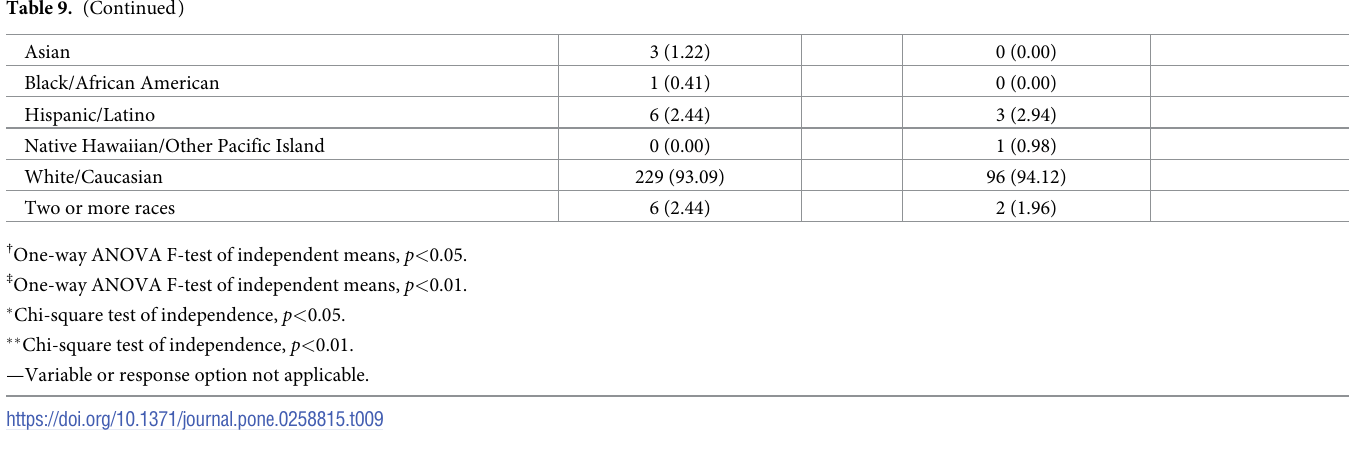
accounted for a majority of the variance explained, with 55.5% explained by the first factor, 38.0% by the second, and 26.3% by the third. Factor analyses using polychoric correlations produced very similar factor loadings and the same interpretations. All items had very high discrimination values (indices ranging from 71.4 to 92.6), with much higher proportions of responses in the highest categories (4 = Requires little effort and 5 = Occurs naturally without effort ) among those with scores in the CARE Scale mean score upper quartile compared to those with scores in the lower quartile. In considering the item dis- crimination curves (Fig 6), only two items had proportions of highest category responses at or above 20% for the lowest CARE Scale mean score decile group and no items had proportions above 25% for this group, indicating good discrimination among lower-scoring respondents. Three items reached 90% or higher proportions by the 6th decile group, and four items reached 90% by the 7th decile group. These items do not discriminate as well among the upper ranges of responses. In all category response curves for all items (Fig 7), all five response options reached a local maximum across the combined distributions and in the logical order, indicating that there are an appropriate number of response options that are ordered as expected.